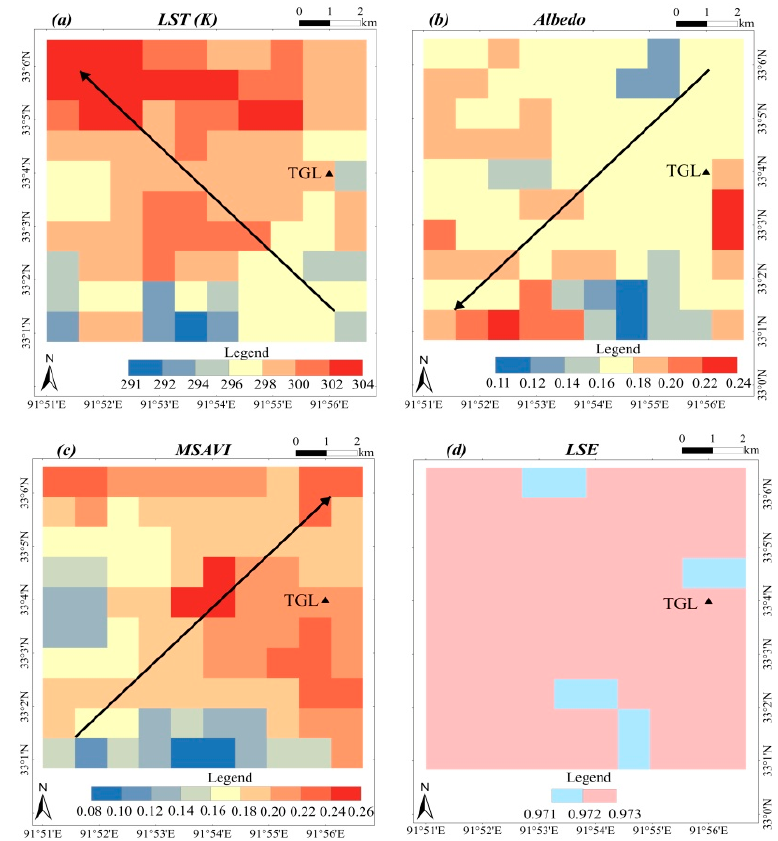
Figure 11. The spatial distribution characteristics of the land surface temperature LST ( a ), land surface albedo Albedo ( b ), MSAVI ( c ), and land surface emissivity LSE ( d ) in the study area.